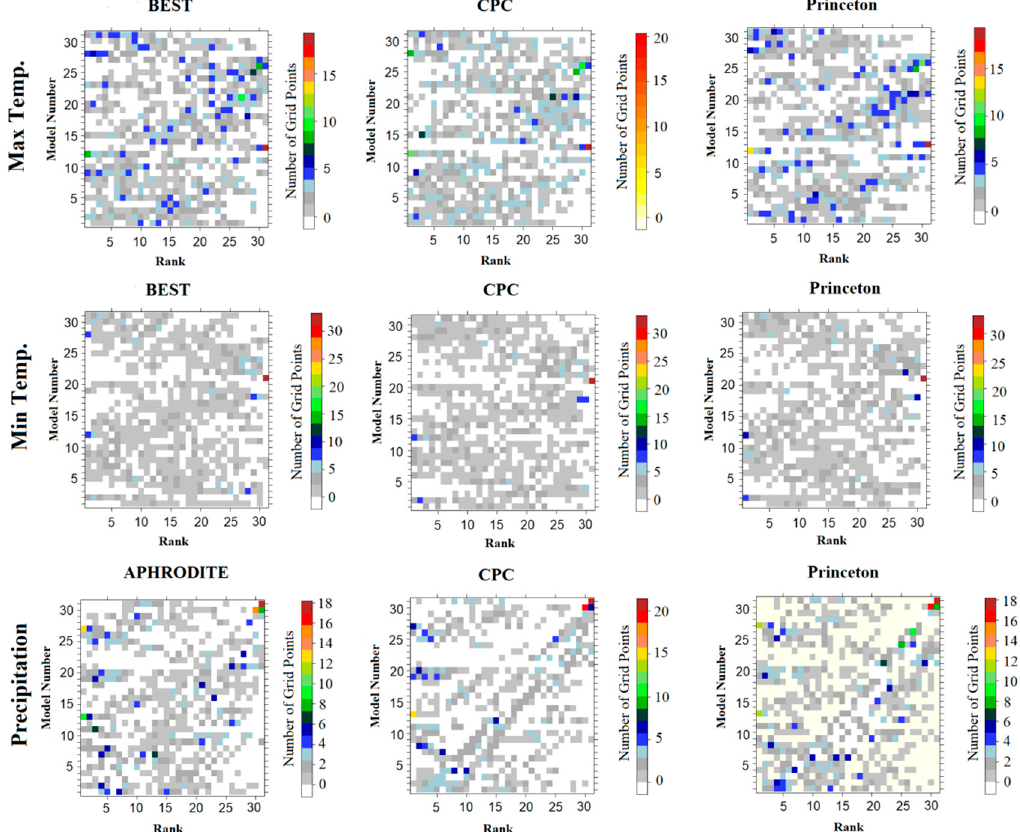
Figure 4. Ranking of the GCM according to their performance in replicating maximum and minimum temperature and precipitation. The x -axis represents the rank of the GCM while the y -axis represents the GCM number as described in Table 2. The color bar shows the number of grid points.